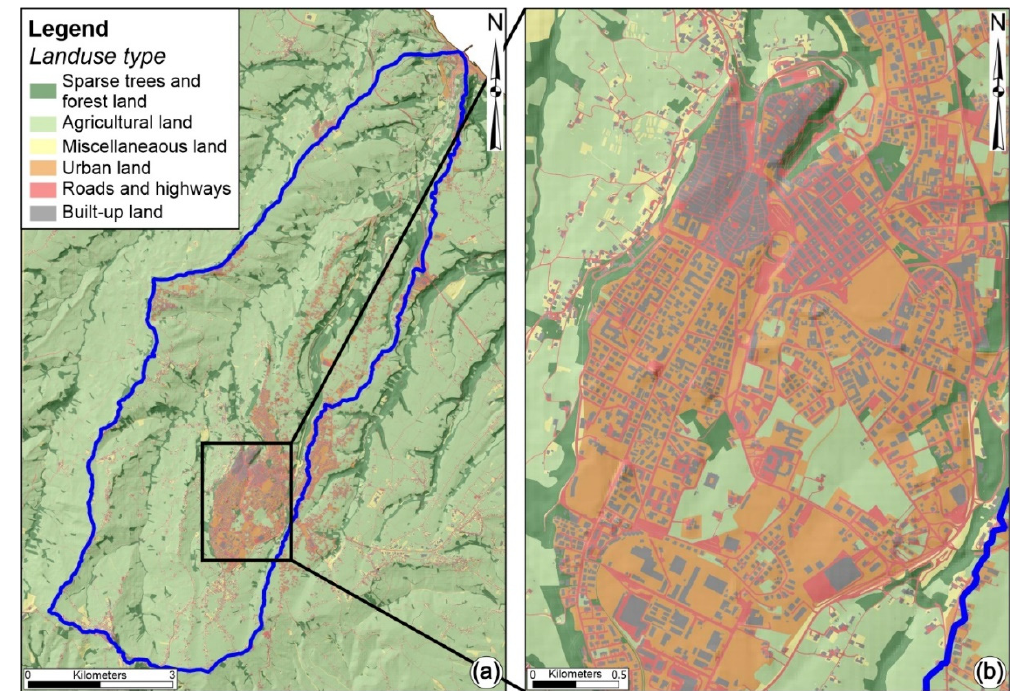
Figure 12. Land-use map. ( a ) Feltrino Stream basin; ( b ) detail of the urban area of Lanciano. Blue line: Feltrino Stream basin.